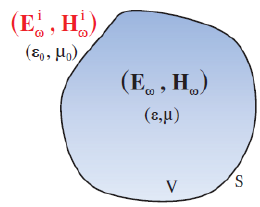
In Figure 1, V and S stand for volume and surface respectively. In two dimensional structures V and S are paper to make the analysis